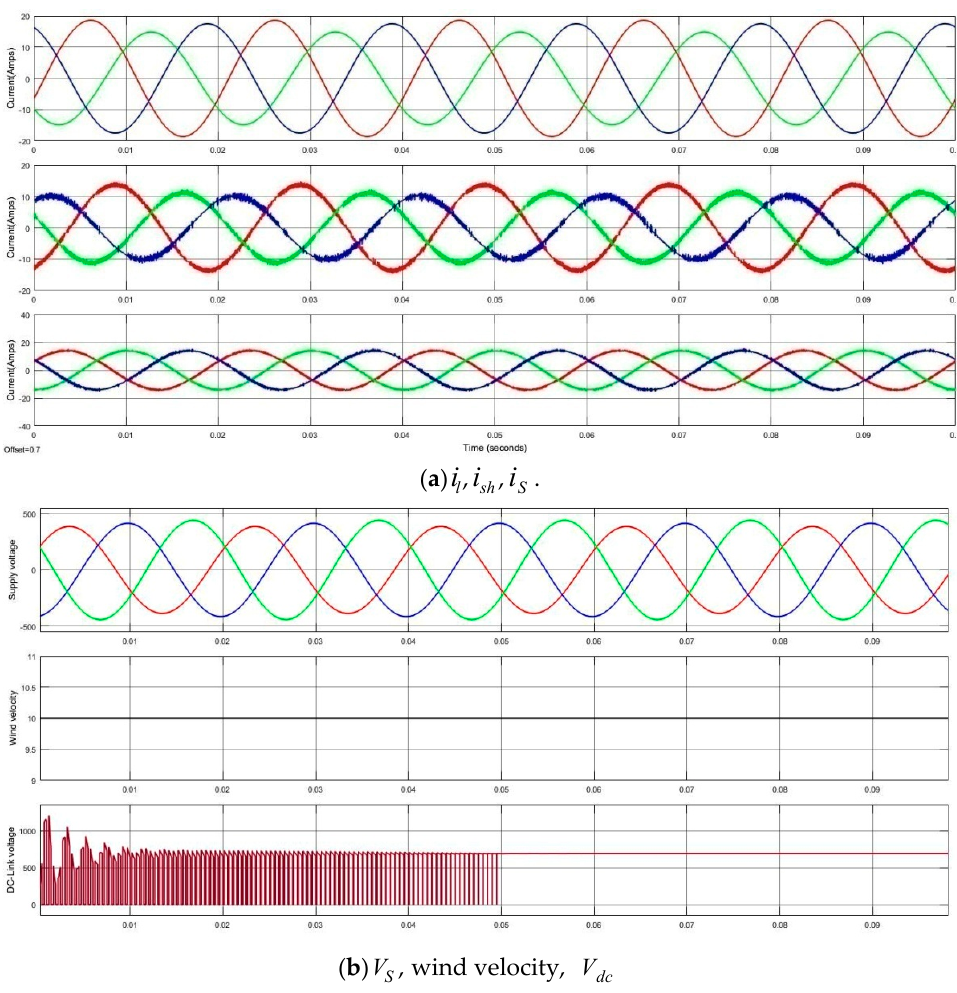
Figure 19. Waveforms for case 5.